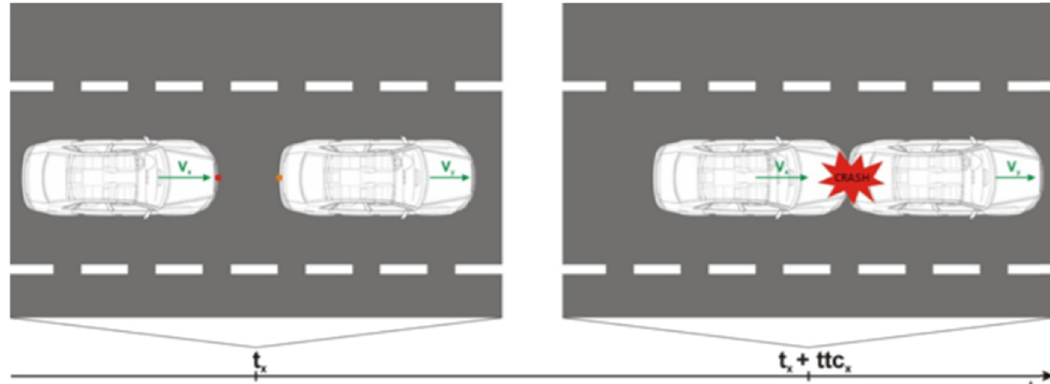
Figure 13: TTC – interpretation source: “ authors ” own